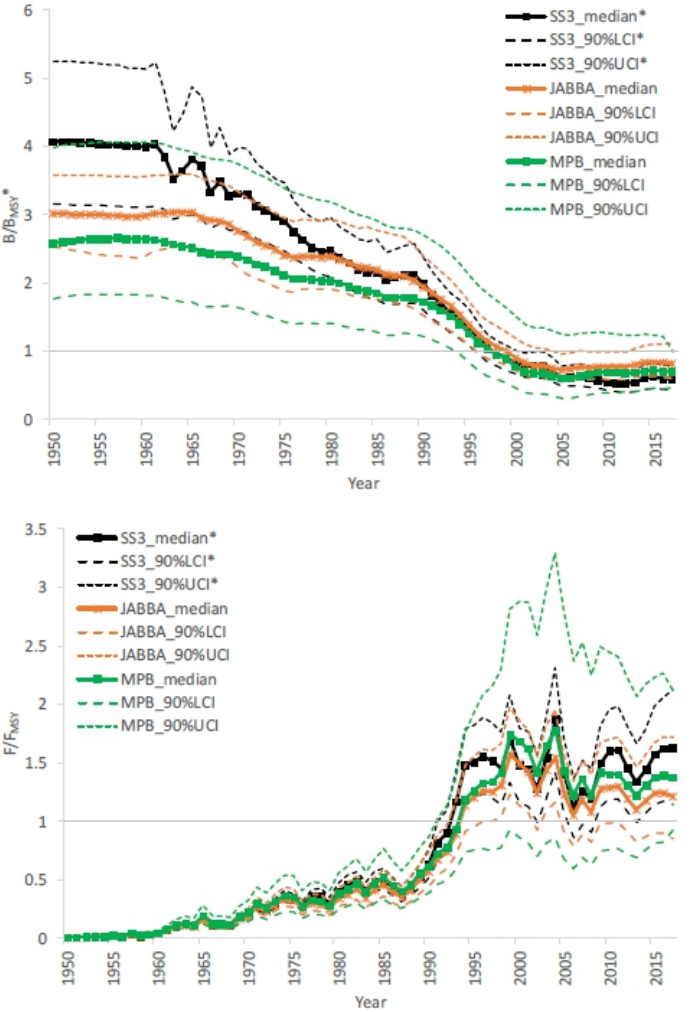
Figure 3. Comparison of the results from different models between 1950 and 2017 for Atlantic BET with 90% confidence intervals. * indicates the results from SS3 are distinguished from the other two models and decided as the stock assessment recommendations to the Commission. Reproduced from [29], with permission from International Commission for the Conservation of Atlantic Tunas, 2022.